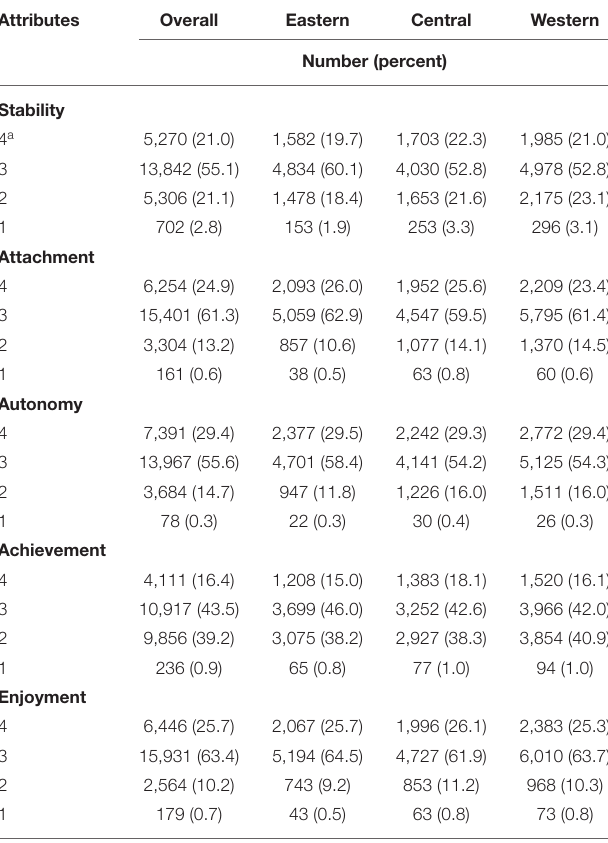
professionals. Attributes Overall Eastern